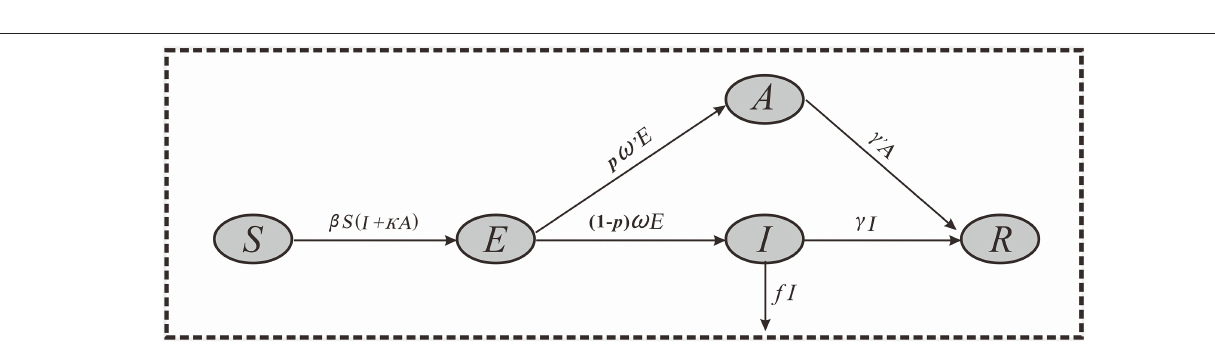
Based on these assumptions, the equations of the SEIAR model are presented as